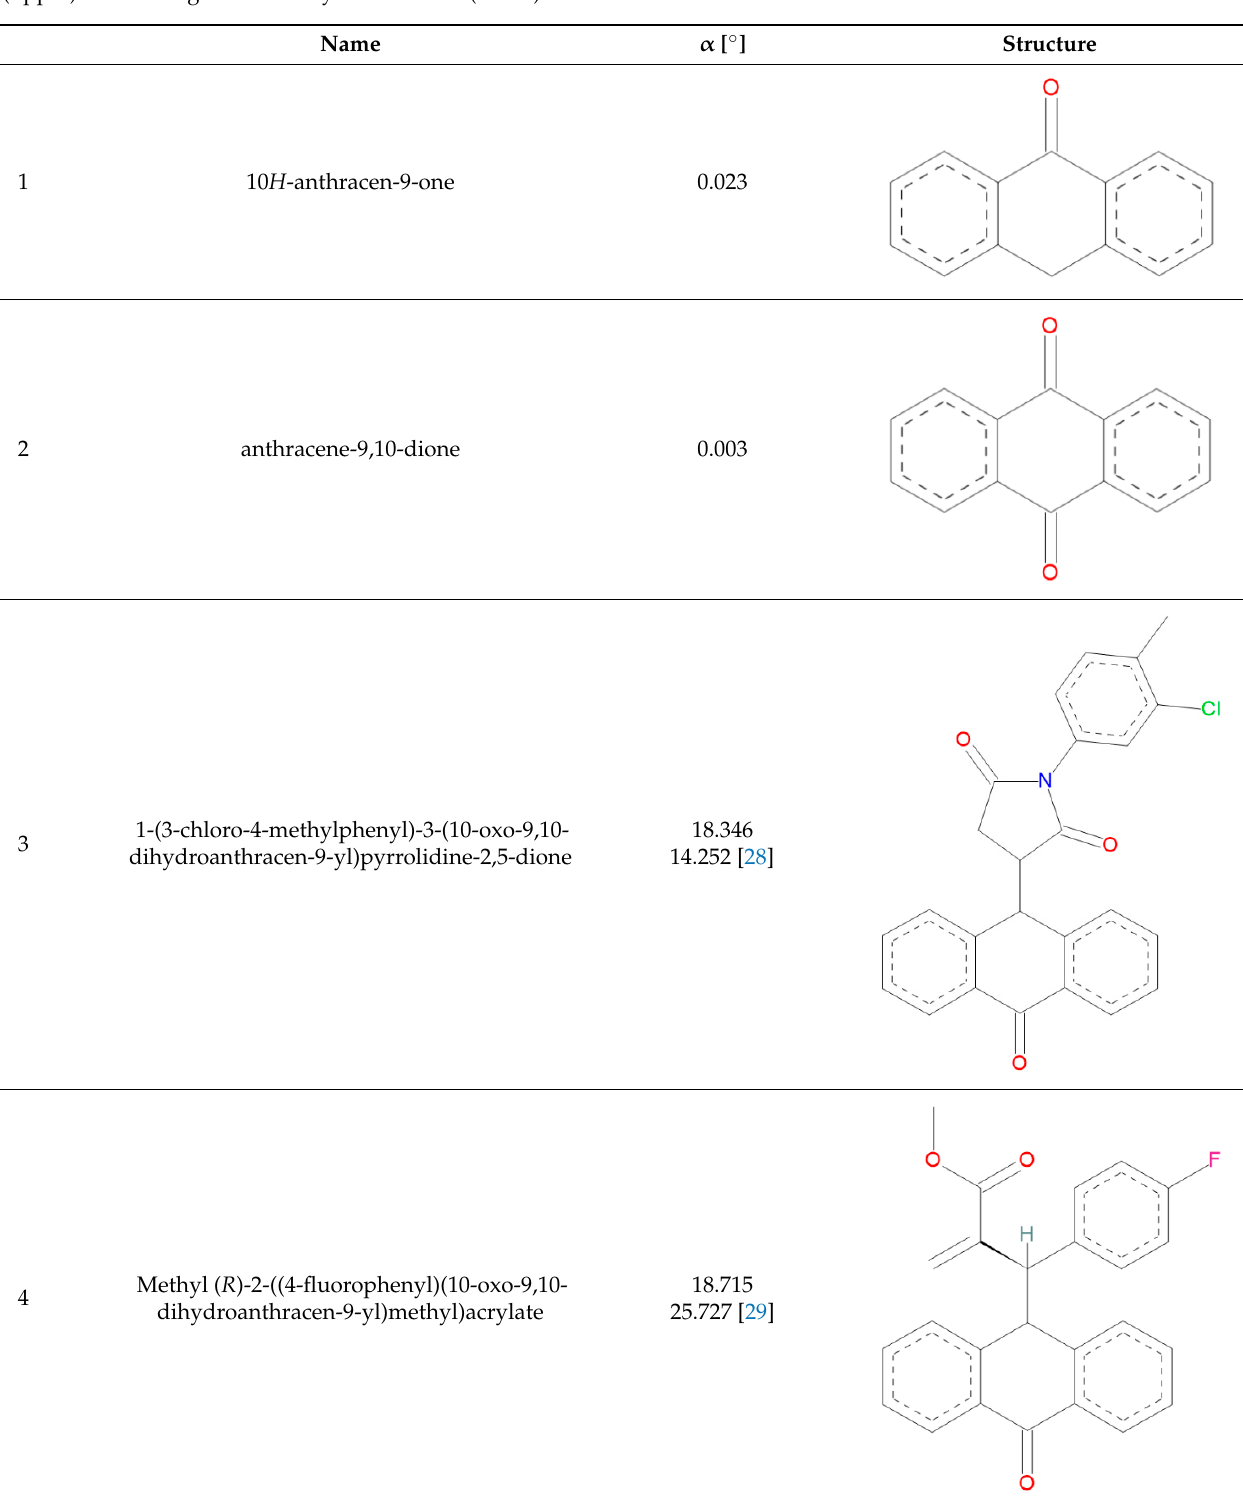
Scheme 4. Definition of the β angle. Table 1. α angle defined according to Scheme 2 for the investigated compounds. Angles for the optimized compounds (upper) and the angles for the crystal structure (lower).